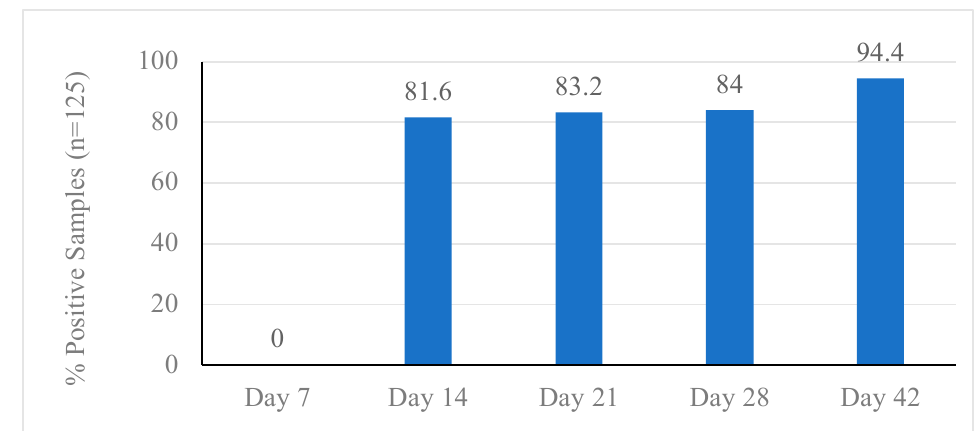
Figure 2. Campylobacter jejuni prevalence in ceca samples during grow-out of flock 1.